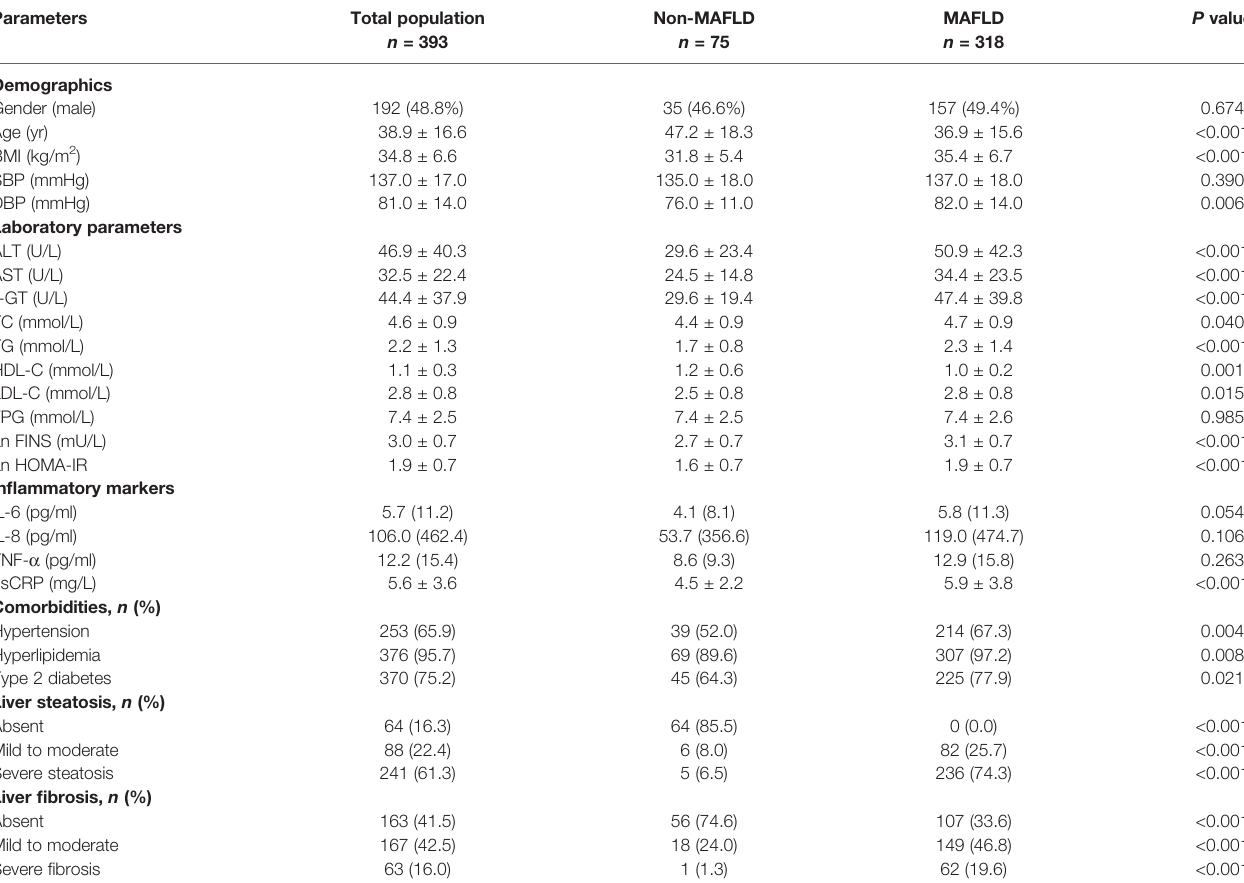
TABLE 1 | Baseline characteristics of the study cohort strati fi ed by MAFLD status.